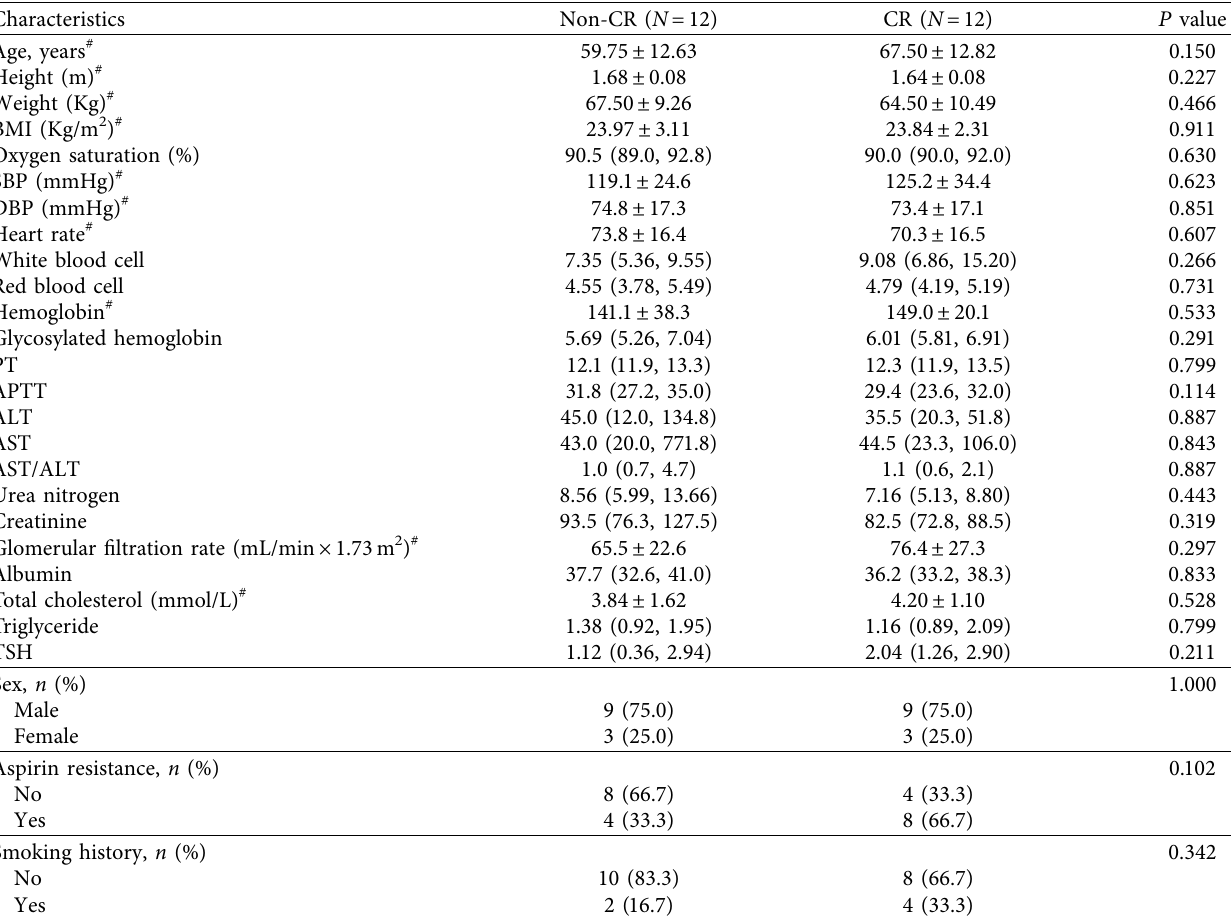
Table 4: Comparison of differences in baseline information between CR and non-CR for Tibetan populations.